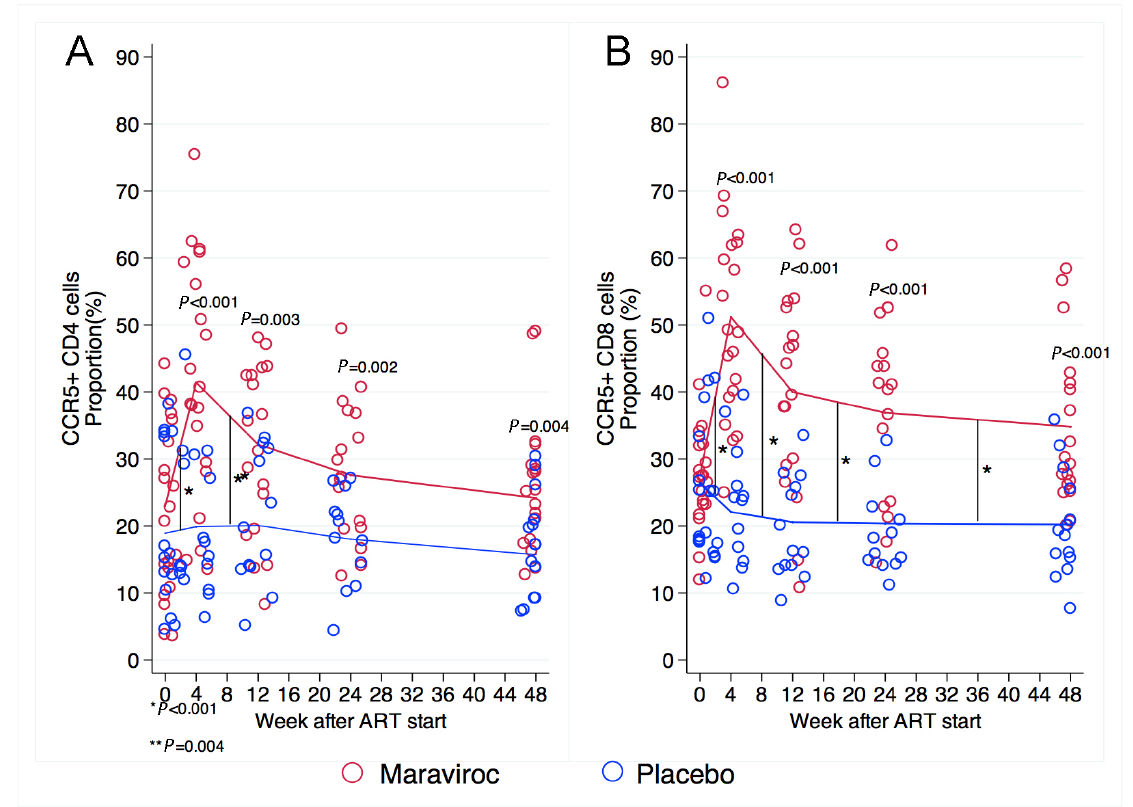
Figure 2. Proportion of CD4+ and CD8+ cells expressing CCR5 at baseline and weeks 4, 12, 24, and 48. (A) The proportion of CD4+ cells expressing CCR5 increased significantly during the first 4 weeks of maraviroc as opposed to the placebo group. This proportion decreased significantly in the next 8 weeks in the maraviroc arm while remaining stable in those receiving placebo. After week 12, the proportions of CD4+ cells expressing CCR5 decreased slightly in both arms. At each time point, the proportions of CD4+ cells expressing CCR5 were higher in maraviroc recipients than among placebo recipients. (B) Similarly, the proportion of CD8+ cells expressing CCR5 was not different at baseline and only increased signifi- cantly during the first 4 weeks of treatment with maraviroc. This increase peaked and fell between weeks 4 and 12 in participants receiving maraviroc and remained stable in the control group. After week 12, these proportions decreased minimally in both arms, but participants receiving maraviroc maintained higher proportions of CD8+ cells expressing CCR5 at each time point. Comparisons between treatment arms for measurements are indicated when P <0.05. Comparisons of the rate of change from 1 time point to the next are indicated by vertical black lines and an asterisk when P < 0.05. The P -values were derived from mixed linear models using linear combination of coefficients after model